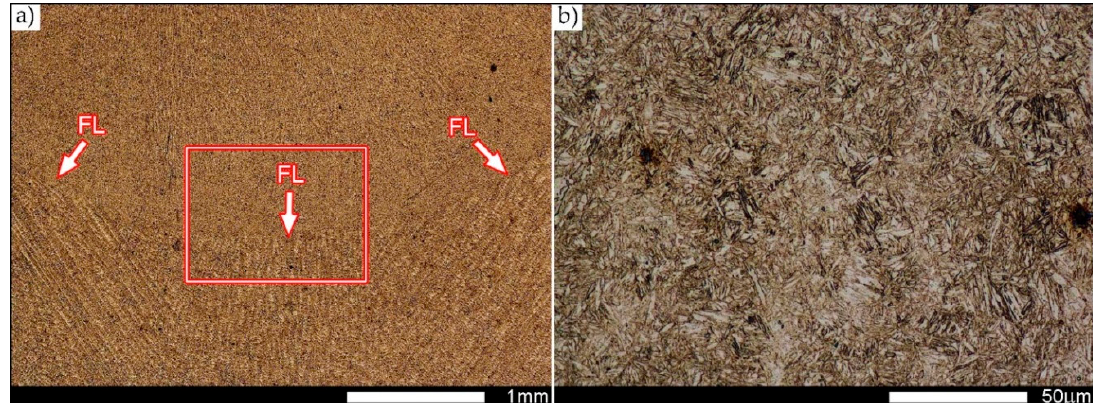
Figure 15. Microstructure of Hardox Extreme welded joint after heat treatment: ( a ) in the area marked WM3 in Figure 6; ( b ) an enlarged image marked with frame in Figure 15a. Structure of fine-lath hardening martensite with weak banding features resulting from former dendritic structure. Faintly outlined fusion line between weld layers 1 and 2 (FL) is marked with arrows. Light microscopy, etched with 2% HNO 3 .